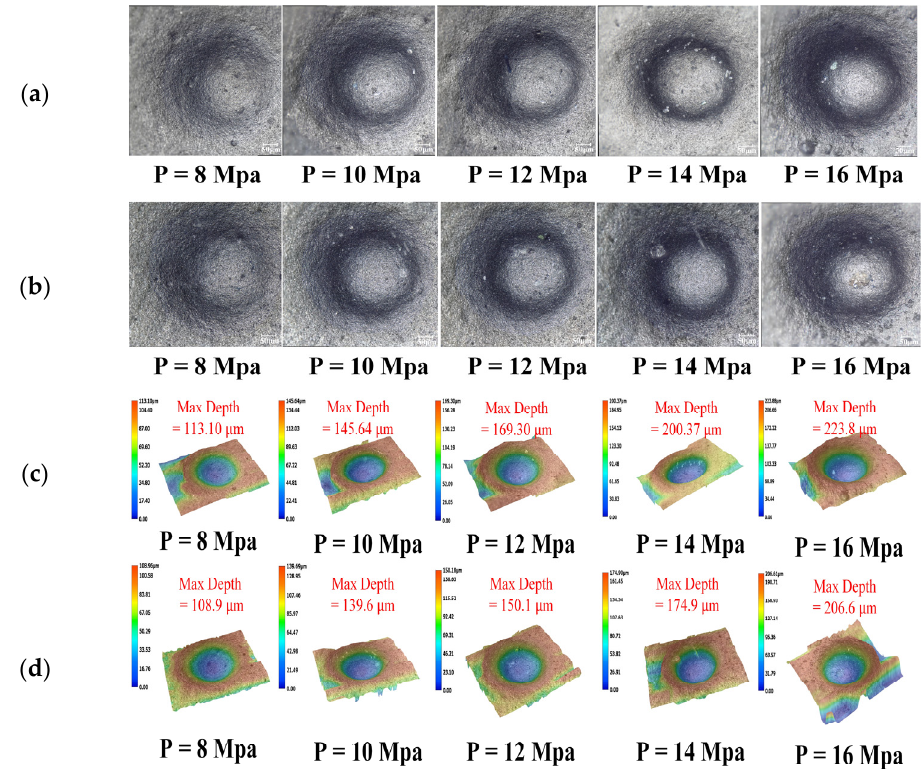
Figure 12. Erosion morphology and depth of cavities with and without self-excited oscillation under different jet pressures: ( a ) Erosion morphology of SEO-AWJM, ( b ) Erosion morphology of AWJM, ( c ) Erosion depth of SEO-AWJM, ( d ) Erosion depth of AWJM.